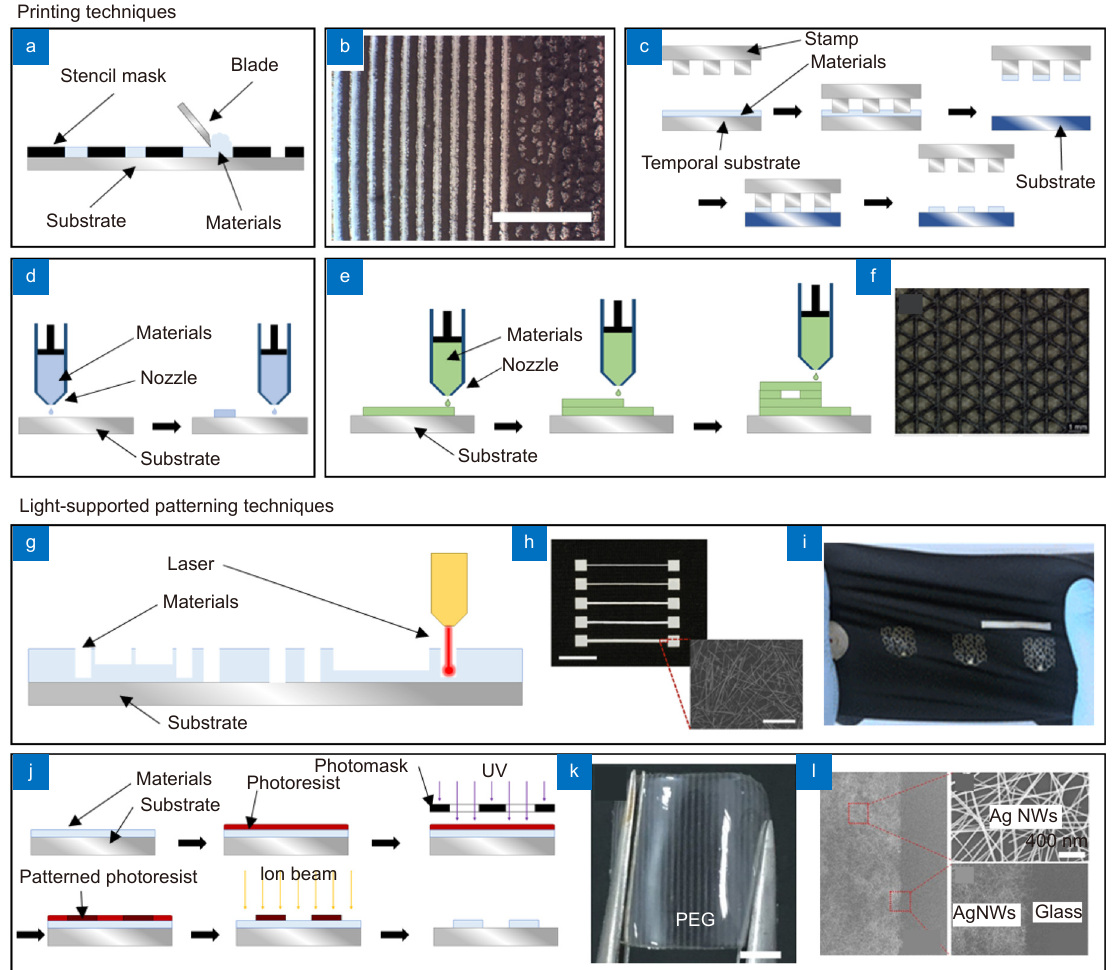
Fig. 4 | Representative fabrication methods of intrinsically stretchable electronic materials. ( a ) Schematic describing stencil printing meth- od and ( b ) optical image of the patterned Ag flake nanocomposite. Scale bar: 10 mm. ( c ) Schematic of a soft lithography method for patterning in- trinsically stretchable materials. ( d ) Schematic showing inkjet printing of intrinsically stretchable materials. ( e ) Schematic description of 3D print- ing process for intrinsically stretchable materials. ( f ) Optical image of 3D-printed graphene/PDMS composite. ( g ) Schematic for laser patterning of intrinsically stretchable materials. ( h ) Optical image of the laser-patterned Ag NW/TPU nanocomposite, laminated on a textile with different line widths. Inset shows an SEM image of the Ag NW/TPU pattern. Scale bar: 5 mm. ( i ) Digital image of a deformed textile patch. ( j ) Schematics de- scribing the photolithography process. ( k ) Optical image of the Ag NW-based micropatterns on polyethylene glycol. Scale bar: 5 mm. ( l ) An SEM image of the Ag NW micropatterns on a glass substrate. Figure reproduced with permission from: (b) ref. 154 , under a Creative Commons Attribu- tion-NonCommercial-NoDerivs 4.0 International License; (f) ref. 158 , (h, i) ref. 160 , American Chemical Society; (k, l) ref. 162 , Creative Commons Attri- bution 4.0 International